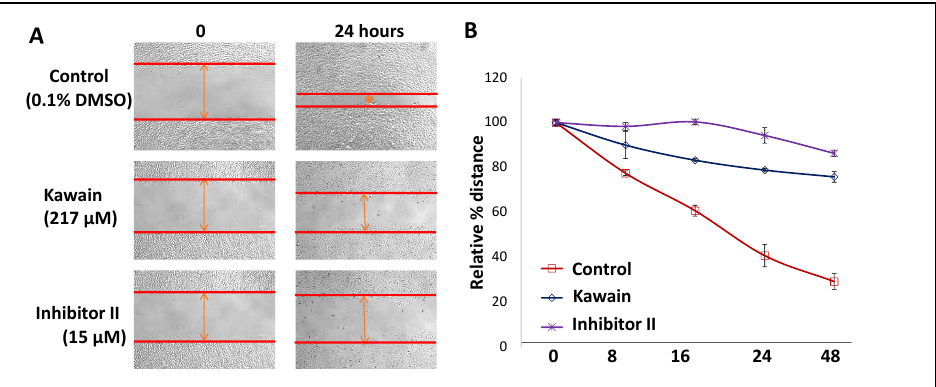
Figure 7. Kawain inhibits cell migration. ( A ) Microphotographs show repopulation of wounded areas of vehicle control (0.5% DMSO) or kawain or inhibitor II treated T24 cells. ( B ) Line graphs of widths of the gap with indicated treatments at 0, 8, 16, 24, and 48 h. Points are percentages of the widths of the gap related to control at 0 h.